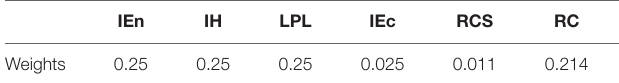
TABLE 6 | Second scheme of weights assigned to the indicators for the sensitivity